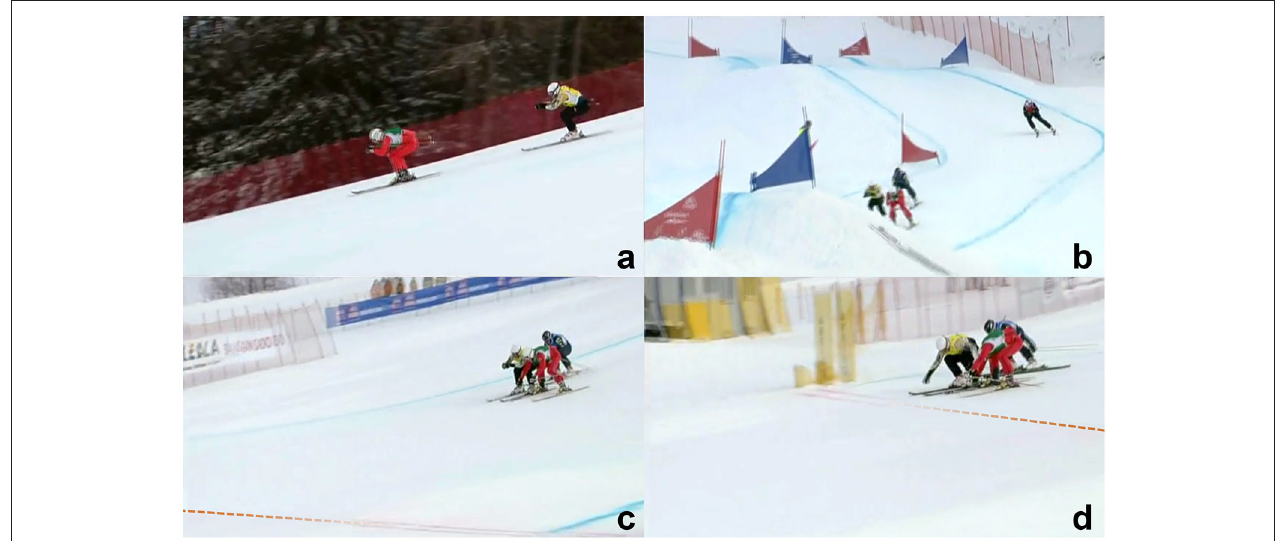
FIGURE 3 | Example of slipstreaming and overtaking in ski cross; FIS Freestyle World Cup event in Innichen—San Candido on December 19, 2010; (a) Scott Kneller (yellow) slipstreaming about 4m behind Alex Fiva (red); (b) Kneller breaks out of the slipstream on the inner side of the last corner before the last jump; (c) shortly before the finish line (dashed), Kneller has already overtaken Fiva and maintains his aerodynamic position whereas Fiva has already opened up; (d) immediately before the finish line, Kneller is clearly leading; video screenshots from: https://vimeo.com/18009110, © Konrad Rotermund 2010, reproduced with kind permission.